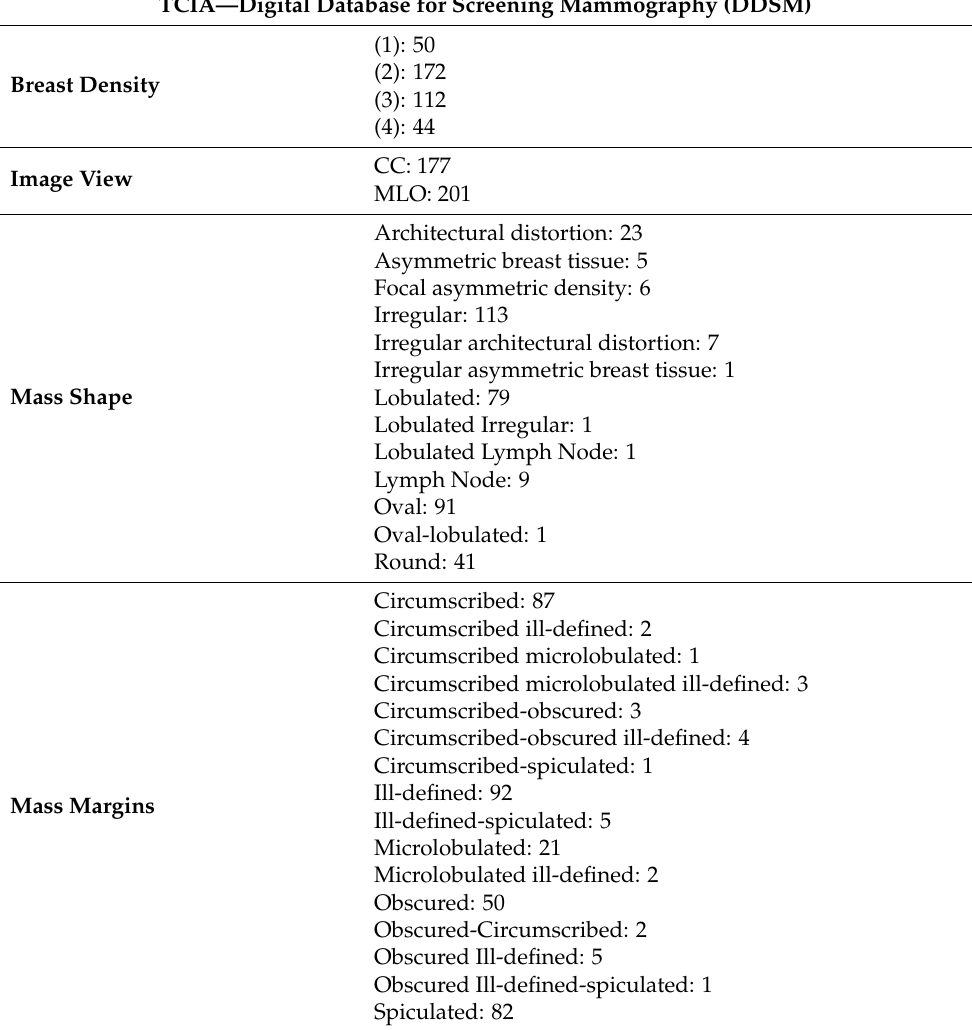
Table 1. Image details from The Cancer Imaging Archive (TCIA) data